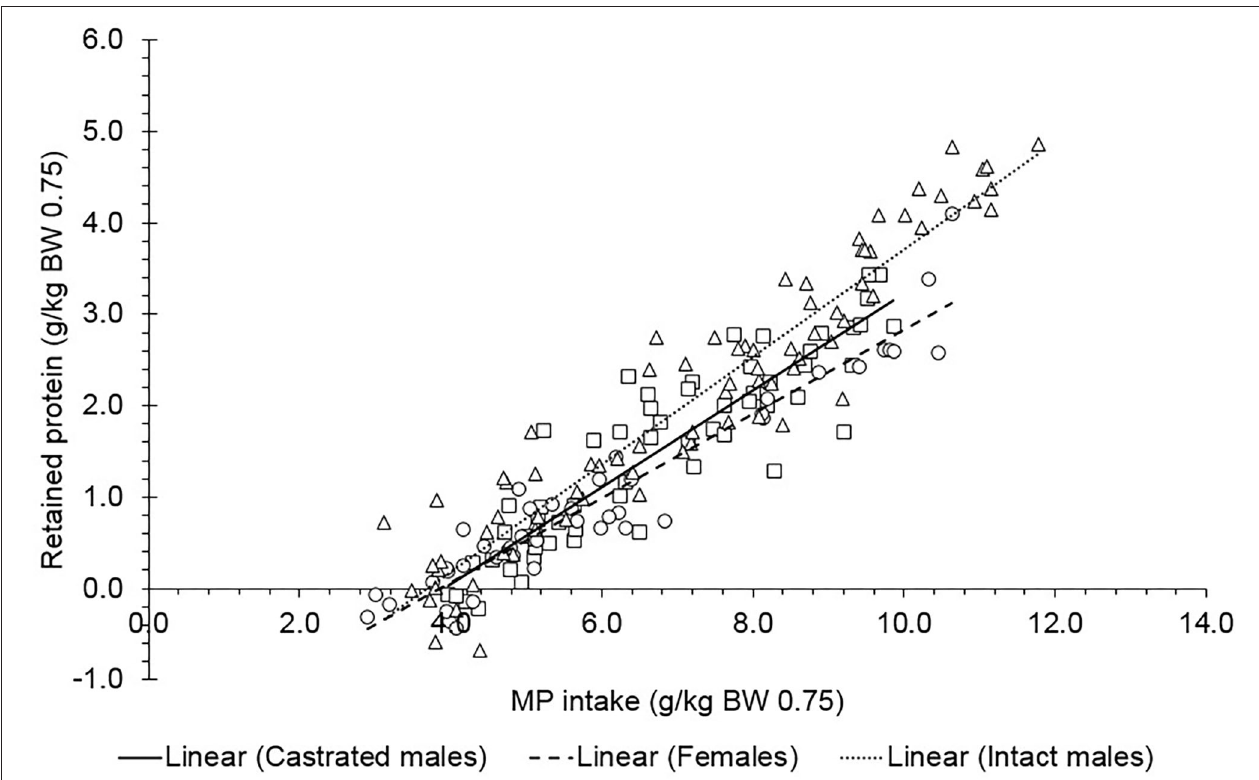
FIGURE 2 | Relationship between daily N retained (g/kg 0.75 BW) and daily N intake (g/kg 0.75 BW) of Saanen goats of different sexes using the N balance method. For all animals: N retained = − 0.509 ( ± 0.0817) + 0.584 ( ± 0.0519) × N intake. The estimated block nested to study variances ( σ 2 b : s ) and the residual variances ( σ 2 e ) were 0.0503 and 0.0482, respectively. The parameters of the equation did not differ between sexes ( P = 0.38). The observations were adjusted for the study